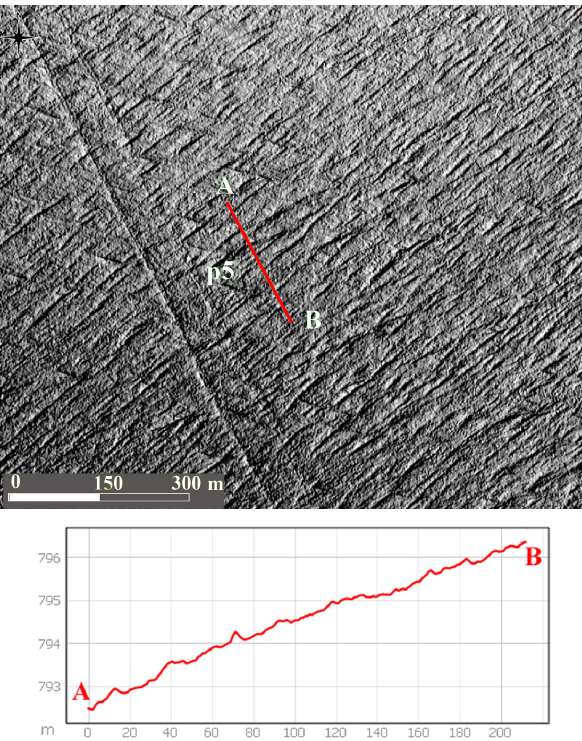
Figure 6. Microtopographic snow/ice features of eolian origin at the site 3: the 1-m gridded hill-shaded map and a cross-section A–B. One can see snow/ice microfeatures of eolian origin, as well as the sledge route crossing the site. For the site location, see Fig.